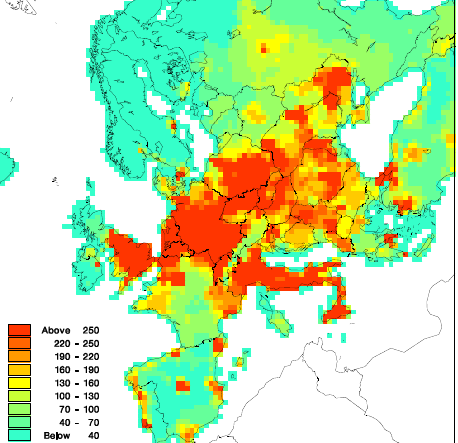
1 Figure 7: 2 Fig. 7. Number of premature deaths per grid cell in Europe 3 4 (DEHM European model domain) as calculated with the inte- grated EVA model system for the year 2000 for the total air pollution levels (scenario All/all). The area of the grid cells is 50km × 50km=2500km 2 , so the colours refer to the number of premature deaths per 2500km 2 . The total number of premature deaths in the whole model domain is 680000, calculated from the number of YOLL (see Table 6) divided by a factor of 10.6 (as used in the CAFE; Watkiss et al., 2005). High numbers of pre- mature deaths (as shown in the figure) require both high levels of annual particle concentrations and high population density. In the year 2020, the number of premature deaths in Europe is estimated to decrease to